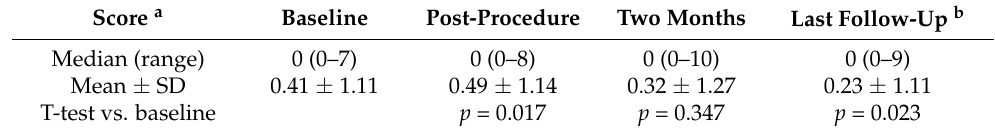
Table 2. Assessment of pain ( n = 300 patients).